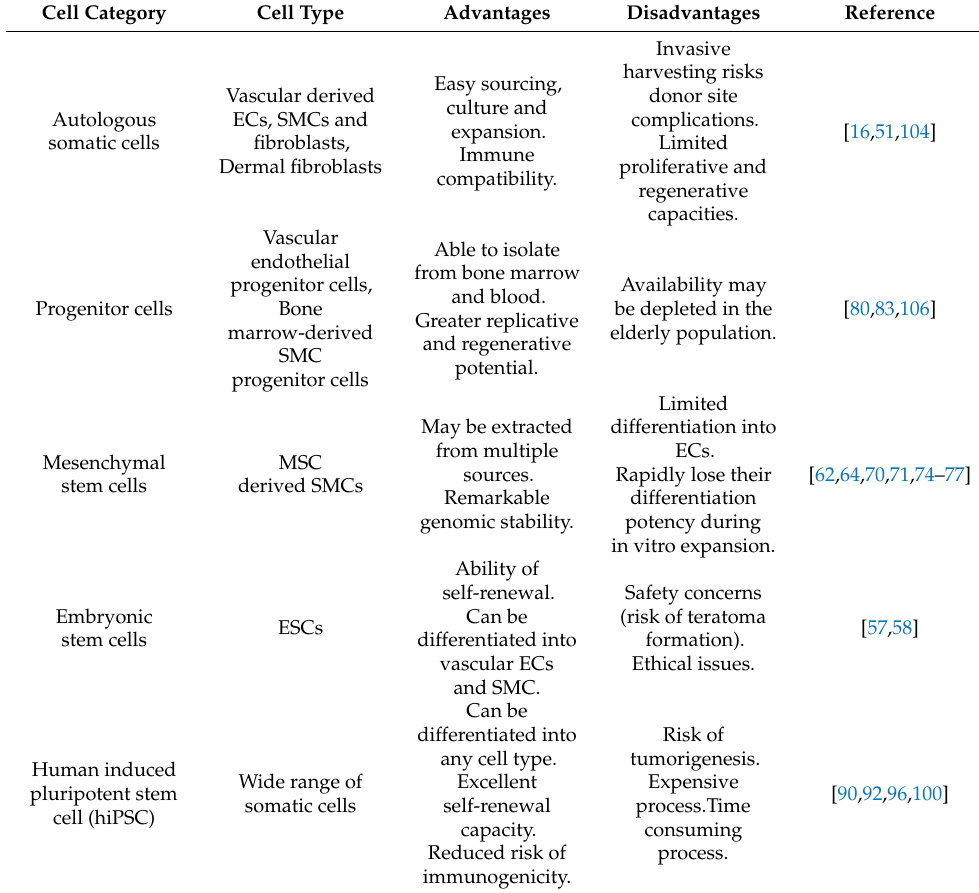
Table 2. Advantages and disadvantages of different cell types in vascular